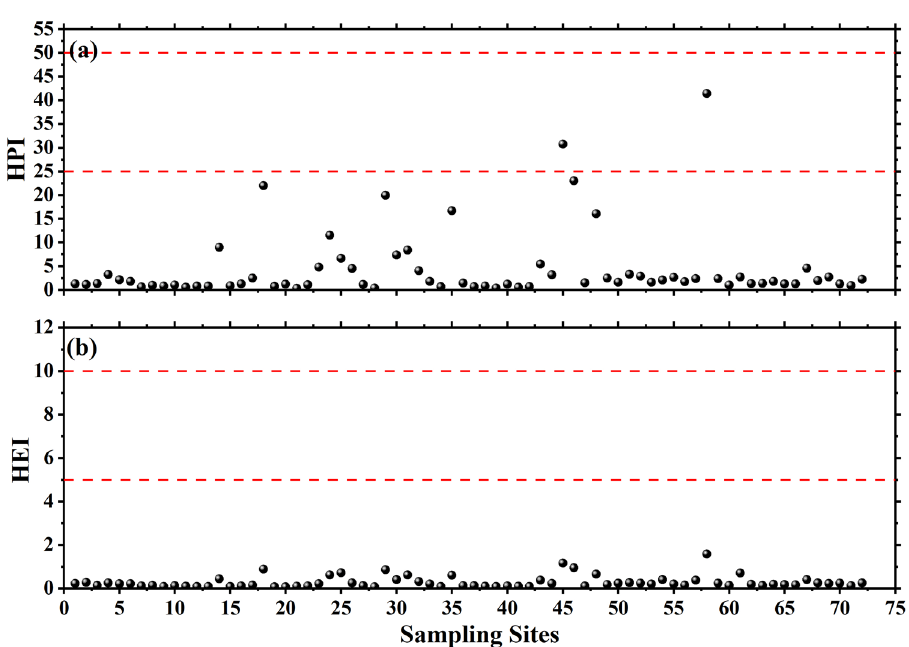
Figure 4. Location-wise variation of HPI and HEI values in potable water of the study